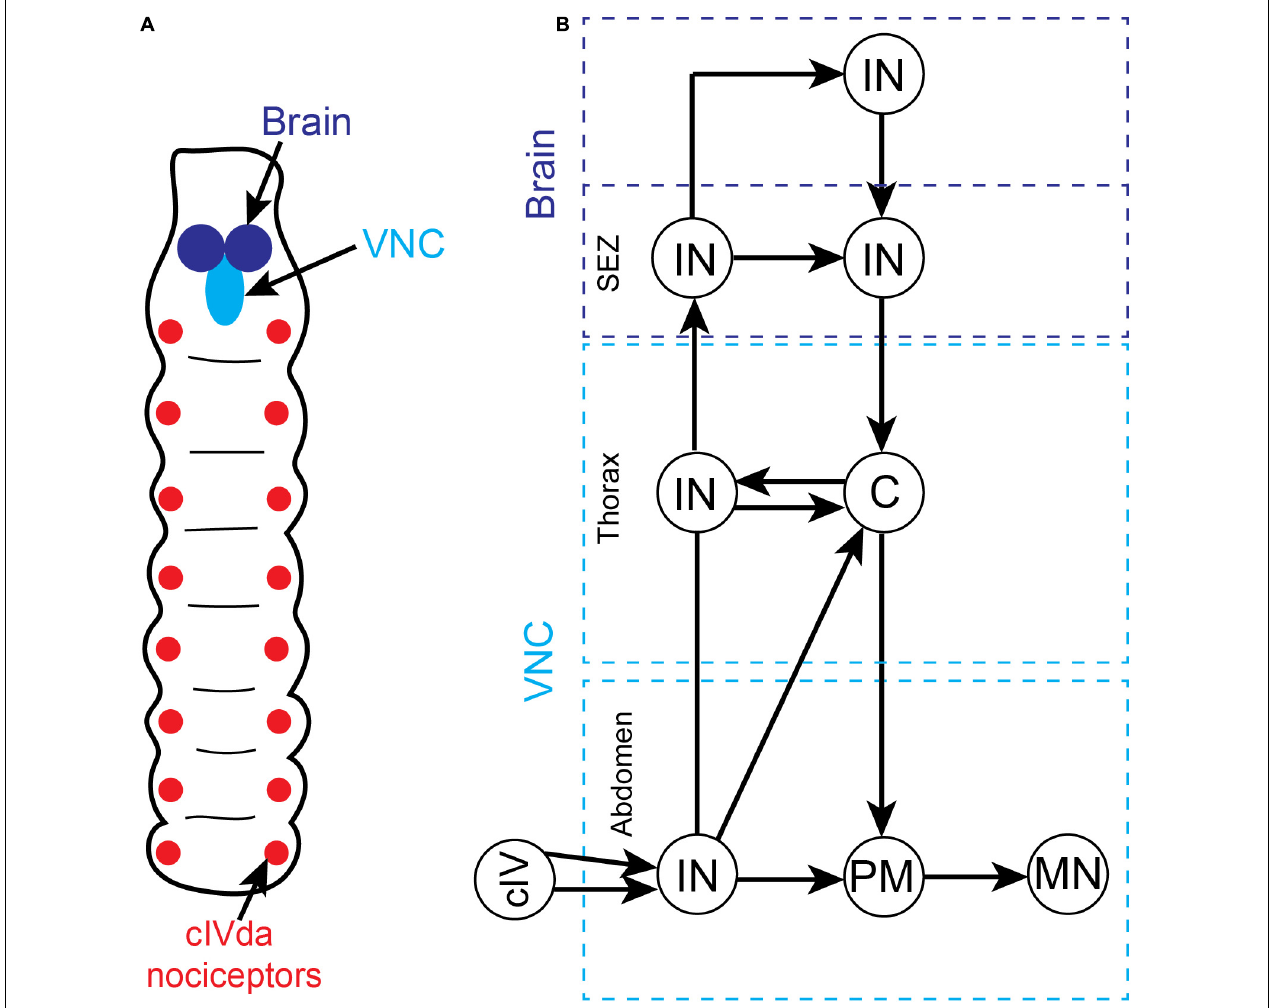
FIGURE 3 | Overview of somatic nociceptive processing in the ventral nerve cord (VNC) of Drosophila larvae. (A) Schematic depiction of segmentally organized Drosophila larva. The brain and VNC are located in the anterior end of the animal. The sensory neurons that are responsive to noxious somatic stimuli (cIVda nociceptors) are segmentally arranged and project axons into the VNC. (B) A simplified circuit diagram of noxious processing pathway and motor outflow in the VNC. While we have not included all the many minor connections, the pathways presented accurately reflect the critical flow of information. There is an ascending sensory pathway involving multiple interneurons at different segmental levels (dashed blue boxes) and a complementary descending motor pathway. Noxious stimuli activate the cIVda nociceptors in the periphery which project into the VNC (light blue dashed boxes) and make contact with segmental interneurons (IN). These interneurons drive local premotor (PM) interneurons which then connect with motor neurons (MN). The segmental interneurons are inter-connected via a series of processing steps that leads into the subesophageal zone (SEZ) and anterior brain regions. Within the descending pathway there are specialized command (C) interneurons in the thoracic segments that control multiple downstream motor